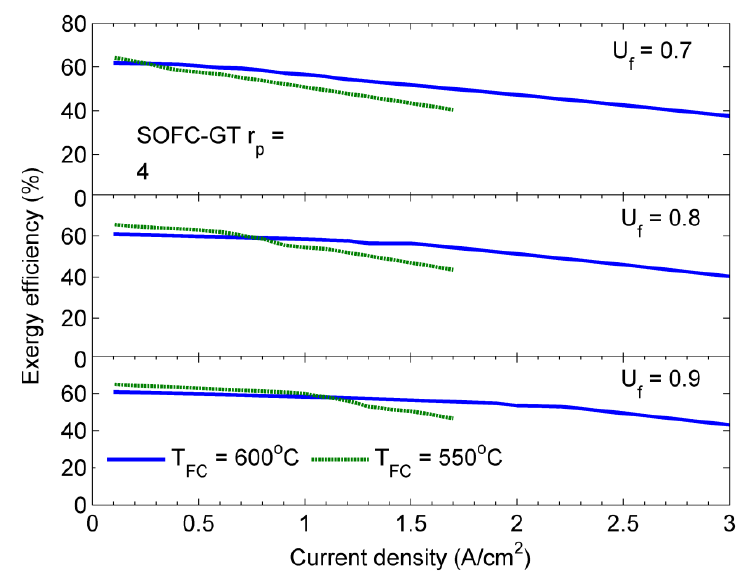
Figure 6. The effect of current density, fuel utilization factor and fuel cell operating temperature on the exergy efficiency of the